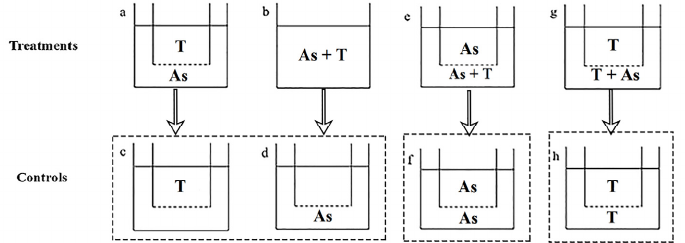
Figure 1. Experimental design for action mode of Akashiwo sanguinea toxicity on phytoplankton and zooplankton. Treatments: ( a ), ( b ), ( e ), ( g ). Controls: ( c ), ( d ), ( f ), ( h ). ( a ): non-contact; ( b ): contact; ( e ) and ( g ): half-contact. ( c ) and ( d ) were the controls of ( a ) and ( b ); ( f ) was the control of ( e ); ( h ) was the control of ( g ). As: A. sanguinea ; T: Rhodomonas salina (Section 2.4.1) and Brachionus plicatilis (Sec- tion 2.4.2), respectively. The dotted line below the insert of the six-well plate means 3 μ m pore size membrane. 2.2. Study 1: Toxic Effects of A. sanguinea on Co-Occurring Zooplankton